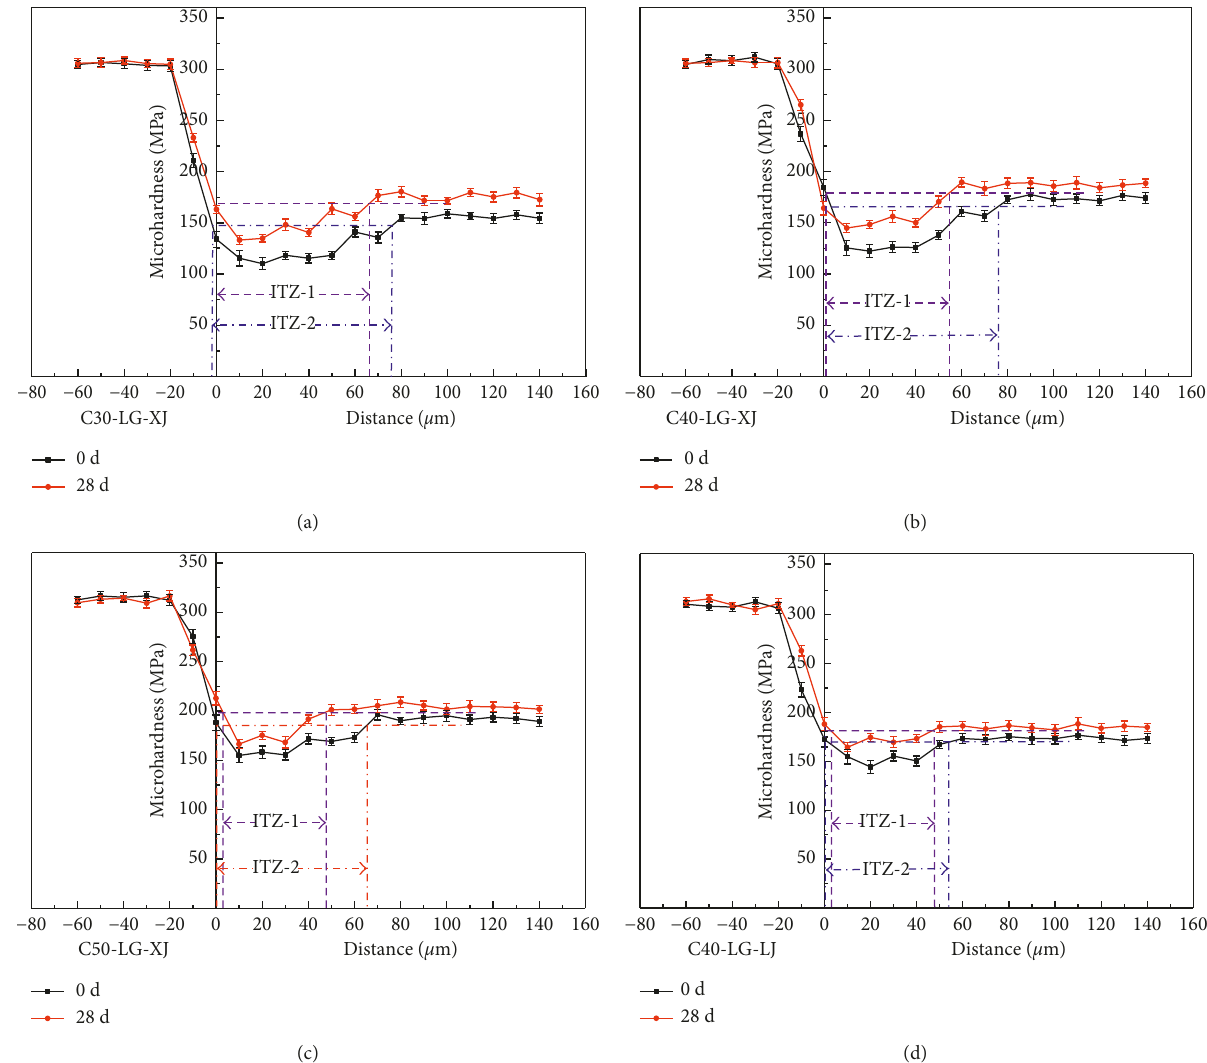
Figure 8: Effect of carbonization on the microhardness of the LG-XJ interface of recycled concrete: (a) C30 (LG-XJ); (b) C40 (LG-XJ); (c) C50 (LG-XJ); (d) C40